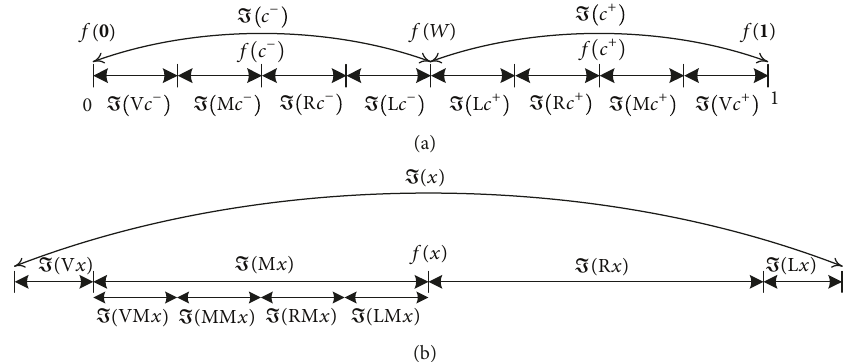
Figure 6: The structure of SQM-values and their related fuzziness intervals of the words of C ∪{ c − , c + } that is given in (a) and of the word x that is given in